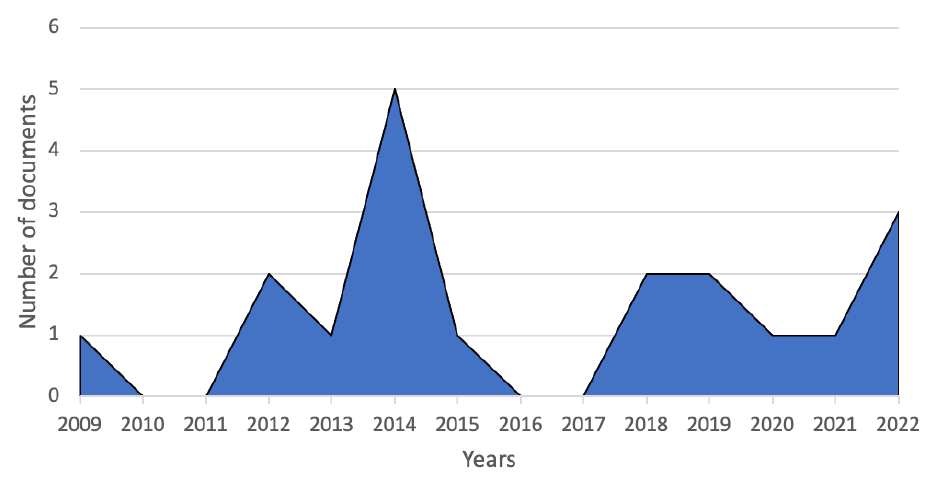
Figure 2. Annual scientific production between 2009 and 2022 using R-studio software and bib- liometrix library of the automated waste collection system (AWCS) scientific literature found in Scopus. Another facet of this anomalous lack of publications which indicates that, albeit the number of published articles is scarce, there is a serious research effort behind vacuum waste collection, is the number of filled patent applications, such as in [18–20], with some of these patents dating back to the 1970s